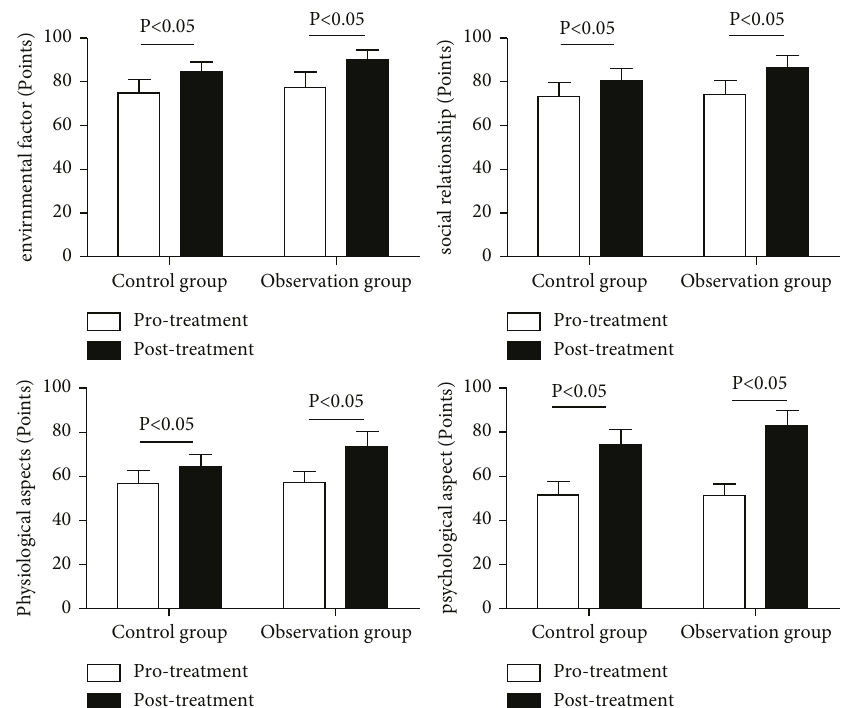
Figure 4: Changes of quality of life scores before and after treatment in the two groups of